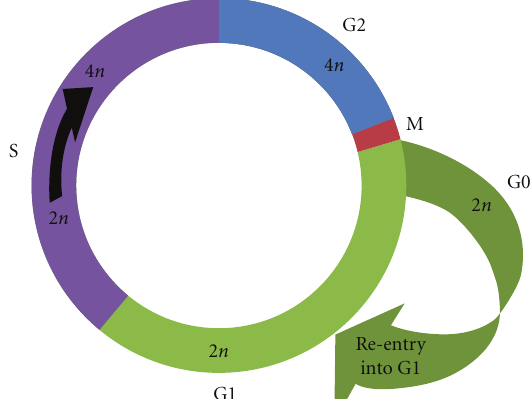
FIGURE 1: Simplified schematic presentation of the cell cycle theory of AD. Quiescent neuronal cells (G0 phase) demonstrate the cell cycle reactivation by either endogenous or environmental mitogenic stimuli followed by reentry into the G1 phase. The G0/G1 phase transition is critical for a postmitotic neuron and potentially causes neuronal cell death. During G1 phase, diploid neurons (chromosomal complement: 2N; number of chromosomes: 46; DNA content: 2C) demonstrate G1-specific cell cycle markers (cyclin D and CDK4/6 complex, cyclin E and CDK2 complex) which are involved in the regulation of G1 phase progression. Cells successfully passing G1 enter the S phase (phase of DNA replication). During the S phase, CDK2/cyclin E should be silenced to repress additional round of replication of genomic DNA. Protein markers of the S phase are A-type cyclins (cyclin A/CDK2 complex). This complex is essential for proper completion of S phase and transition from S to G2 phase. DNA content of cells during S phase changes from 2C to 4C (chromosome number is still 2N, but DNA content after replication is tetraploid). During G2 phase, cyclin A is degraded and cyclin B/CDC2 complex (protein biomarker of late S/early G2 phases) is formed. Cyclin B/CDC2 complex is essential for triggering mitosis. Neuronal cells in G2 phase demonstrate tetraploid (4N) DNA content or, more precisely, possess a nucleus with 46 replicated chromosomes. Chromosomal complement (genomic content) of cells in G2 consists of one set of 46 duplicated chromosomes (DNA content: 4N or 4C: diploid nucleus with replicated chromosomes, for more details see [20]), each having two chromatids—“mitotic” tetraploidy. It is to note that true constitutional polyploidy is a term used to describe cell containing more than two homologous sets of chromosomes (4N or 92 chromosomes, DNA content: 4C). We suggest that postmitotic neurons are able to replicate DNA but are not able to make a G2/M transition and divide into two daughter